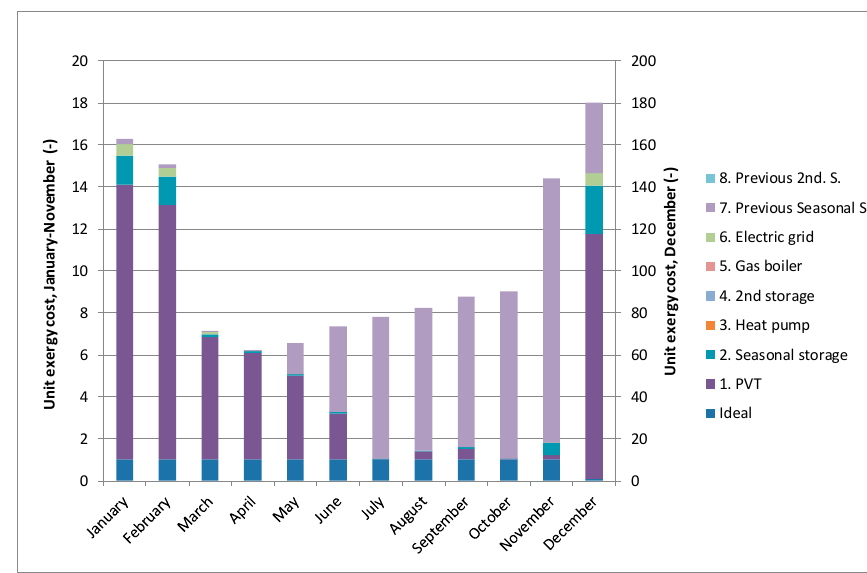
Figure 18. PVT: Cost formation by source.